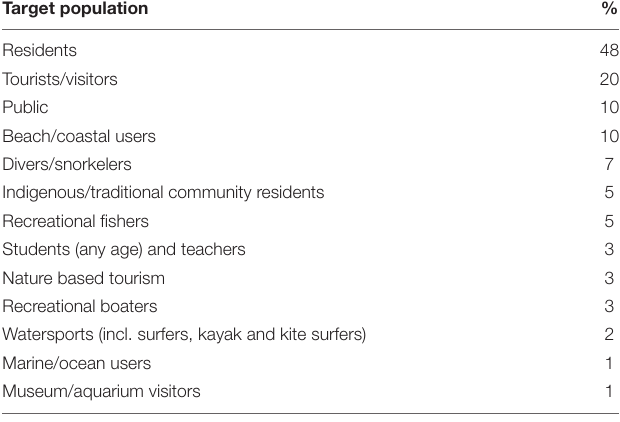
TABLE 4 | Target population of studies ( n =